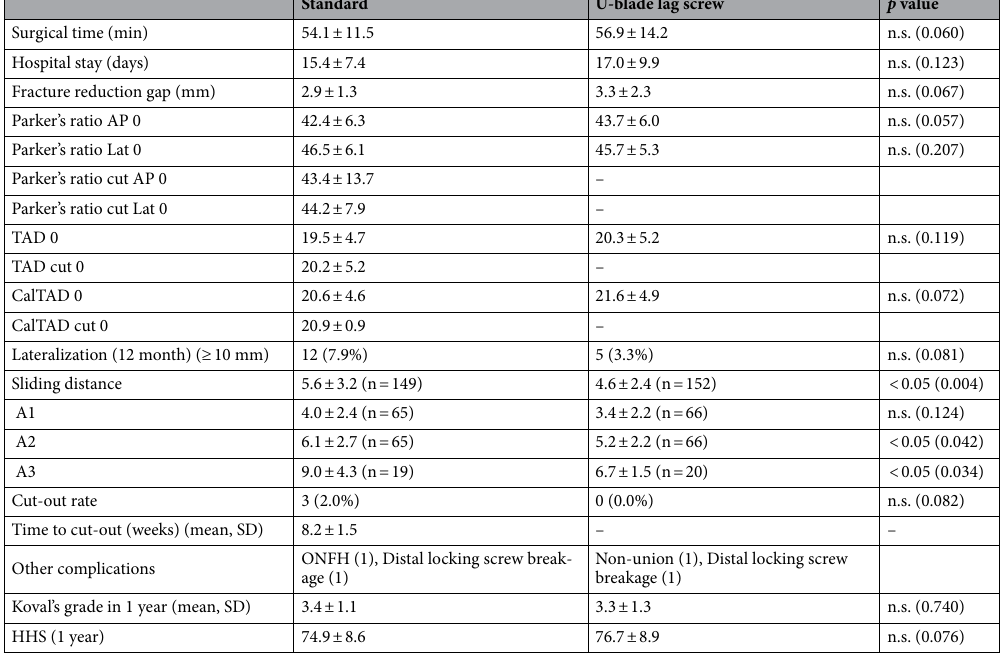
Table 2. Comparison of patients between the standard and U-blade lag screw